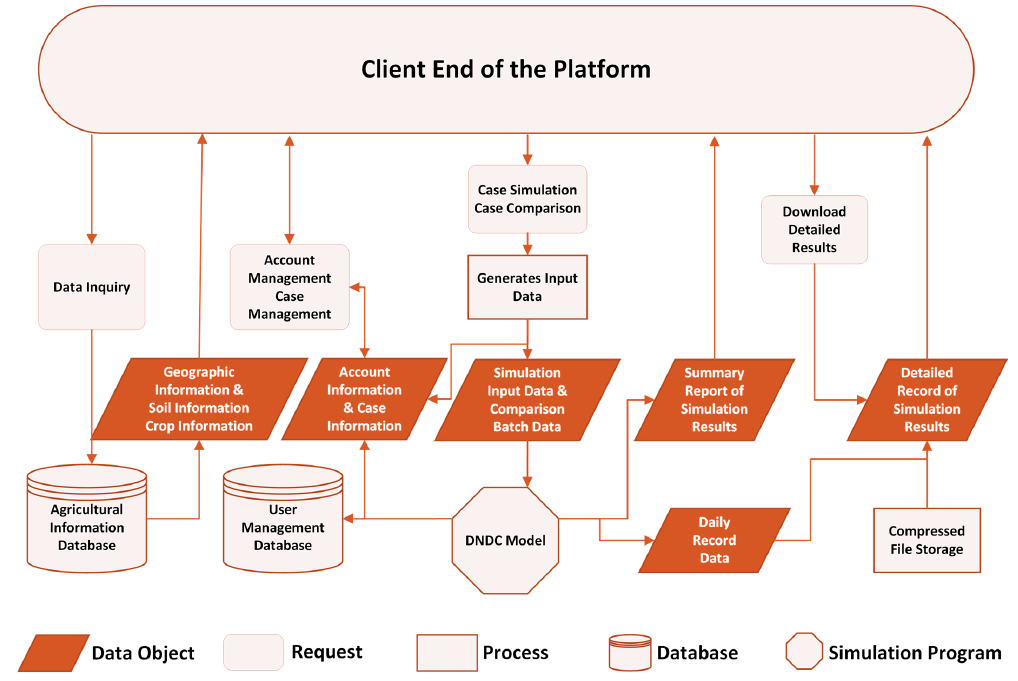
Figure 4. Procedure flowchart of the DNDC online model’s server.